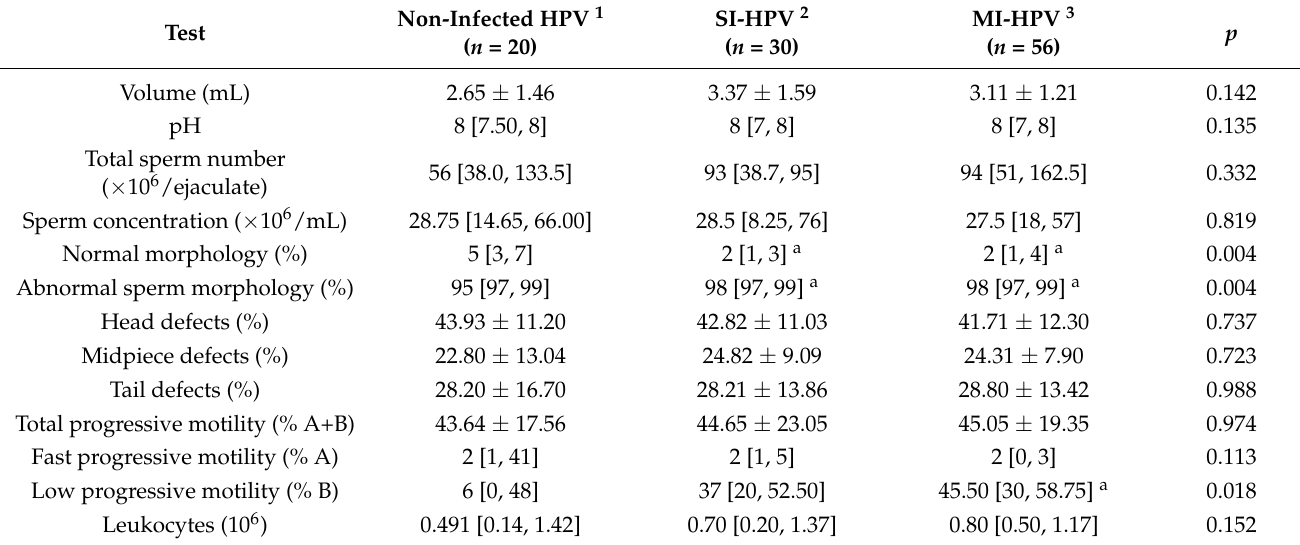
Table 2. Association between HPV positivity and semen parameters and CT positivity ( n =